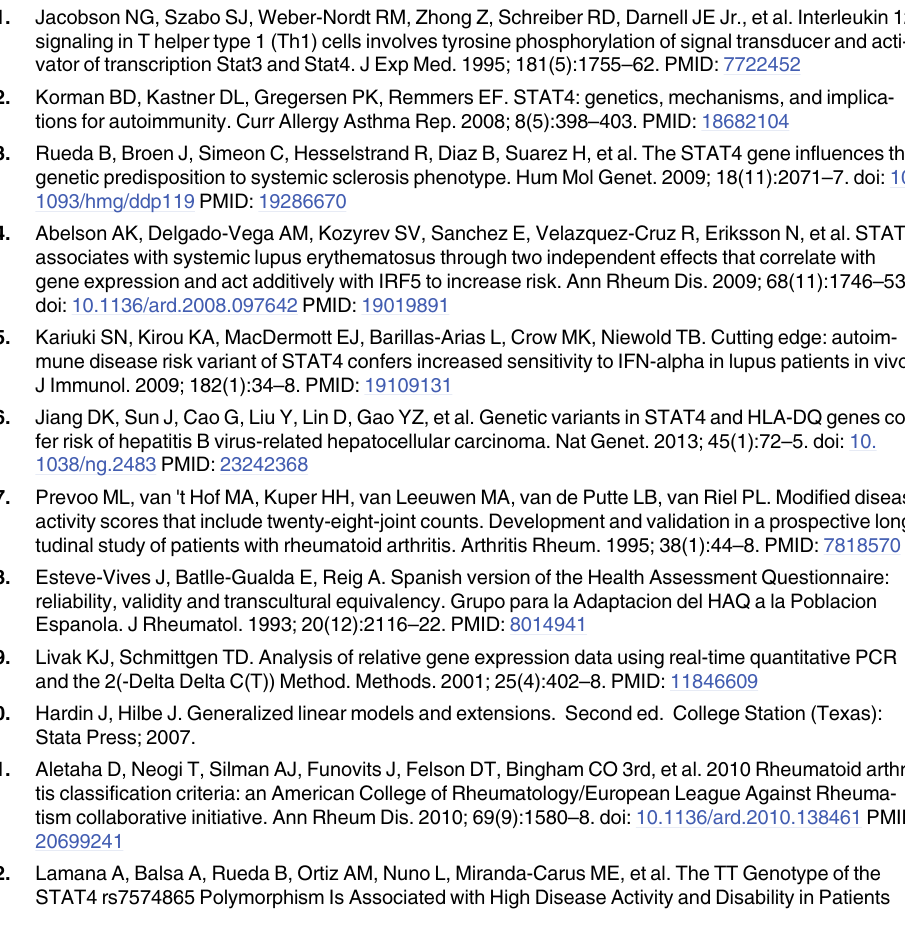
S1 Table. This table describes the characteristics of the subpopulation used for the study of STAT4 mRNA expression showing that it is representative of the whole PEARL study. S2 Table. This table describes the characteristics of the subpopulation used for the study of STAT4 protein expression showing. In this case only subjects with rs7574865 TT or GG genotype were studied among the patients of PEARL